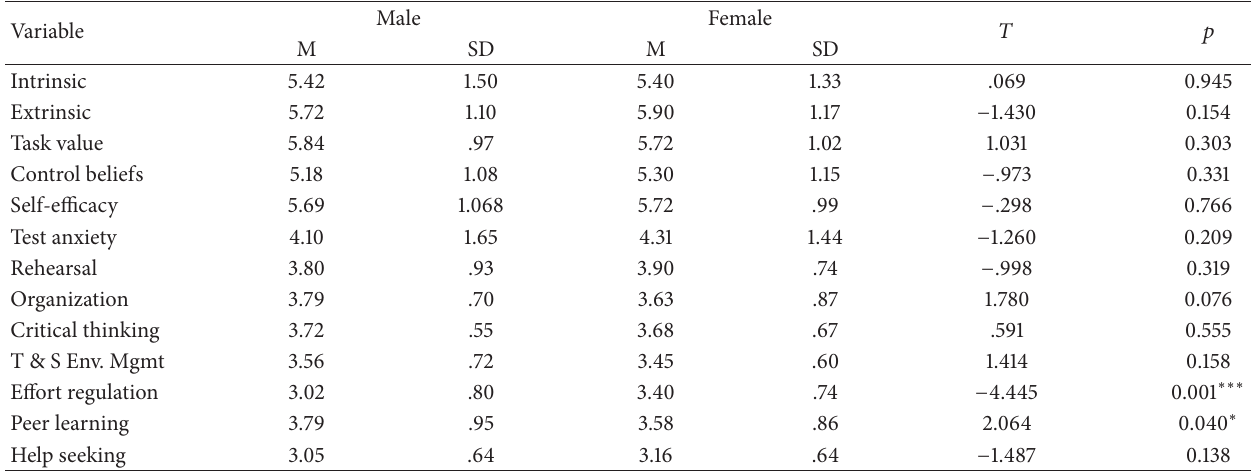
Table 4: Results for motivational beliefs and strategy use for gender (𝑛 = 323) .